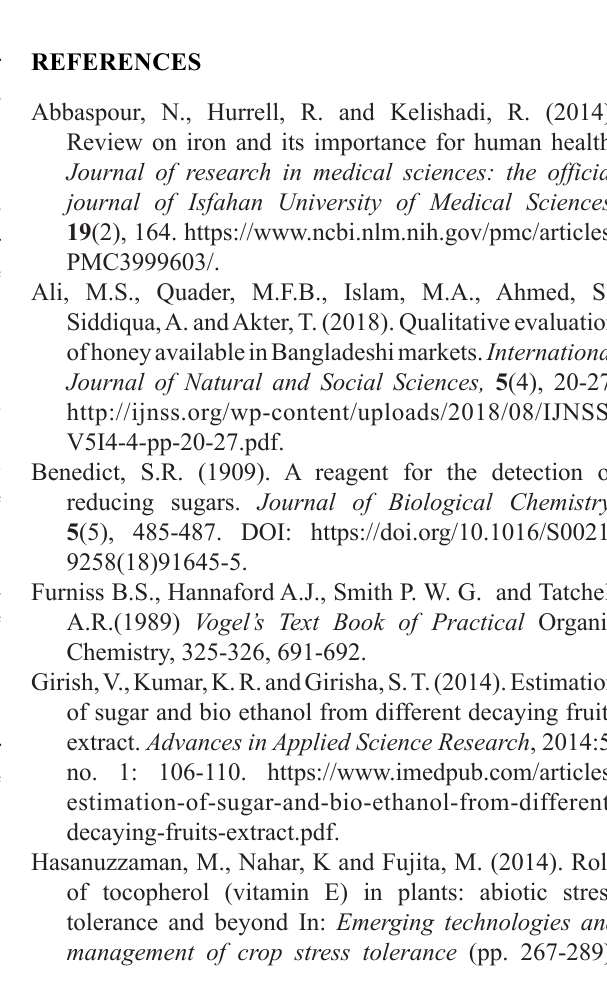
Figure 2: Non-reducing sugar content of adulterated jaggery samples with